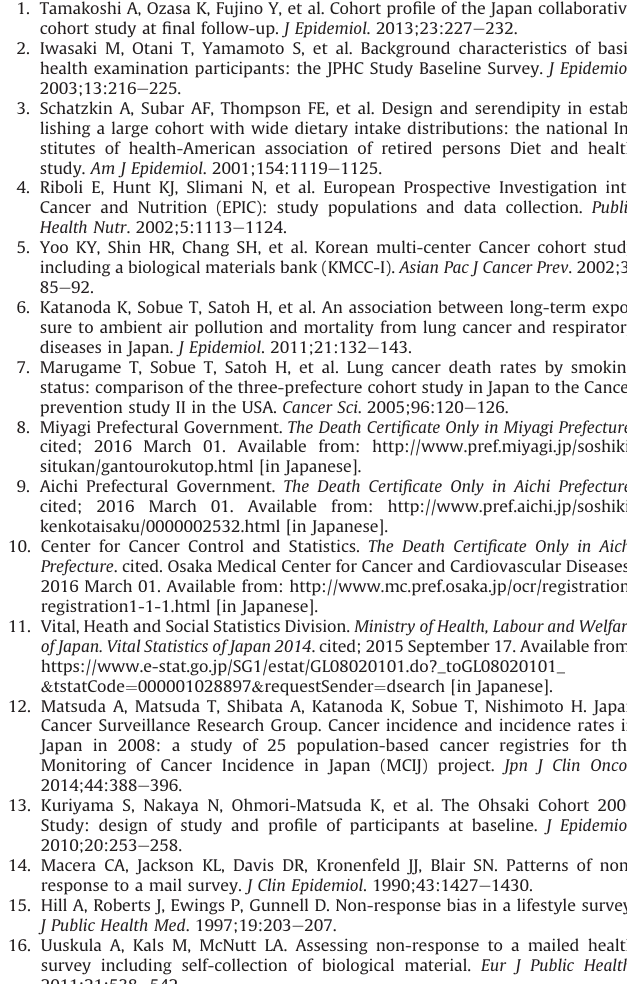
status: comparison of the three-prefecture cohort study in Japan to the Cancer prevention study II in the USA. Cancer Sci . 2005;96:120 e 126. 8. Miyagi Prefectural Government. The Death Certi fi cate Only in Miyagi Prefecture . cited; 2016 March 01. Available from: